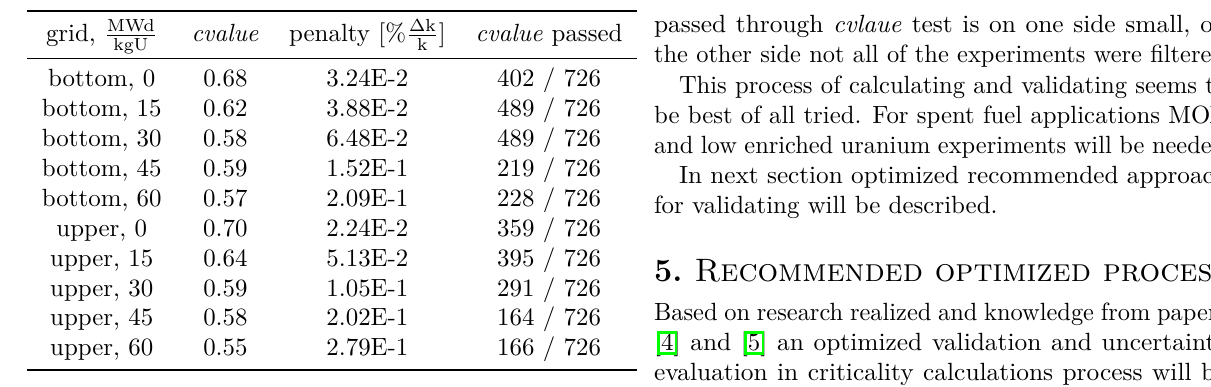
Table 2. Comparison of wet spent fuel storage applications with low enriched uranium and MOX fuel experiments, variable cvalue .